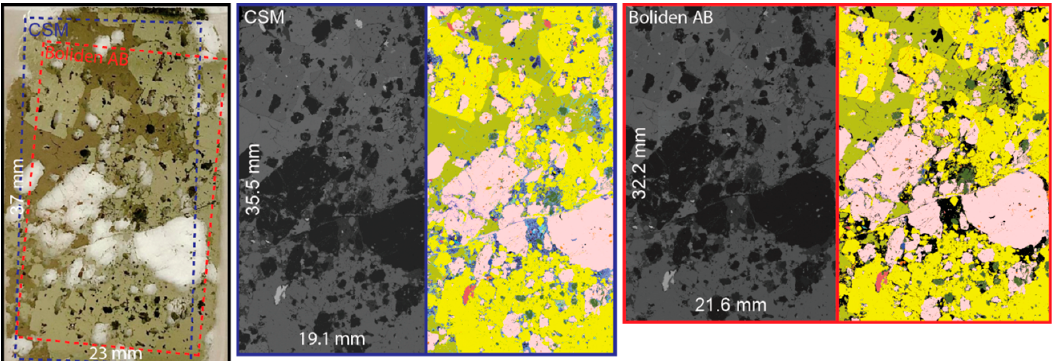
Figure 4. Optical scan of the sample and corresponding QEMSCAN ® images (backscattered electrons (BSE) and mineral map) from Camborne School of Mines (CSM) and Boliden AB.